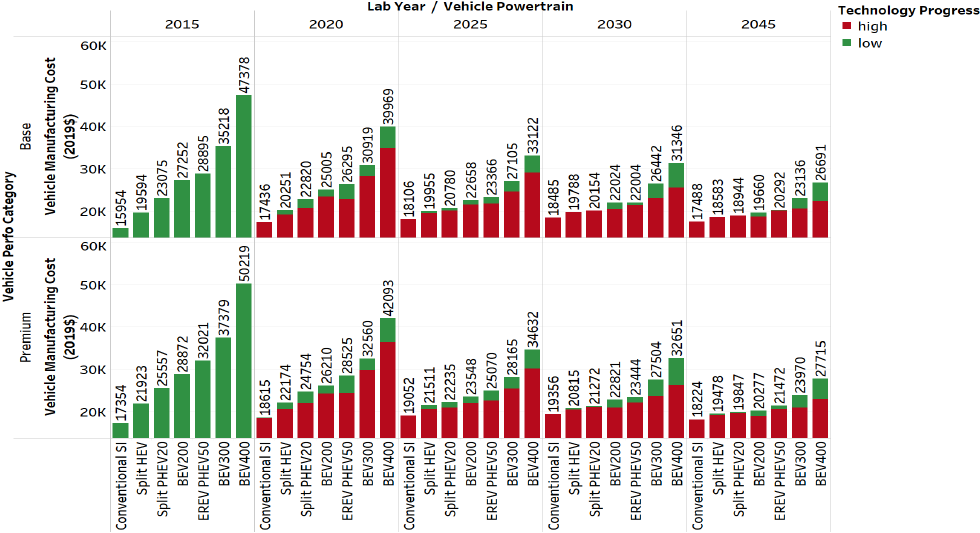
Figure 13. Manufacturing cost of midsize